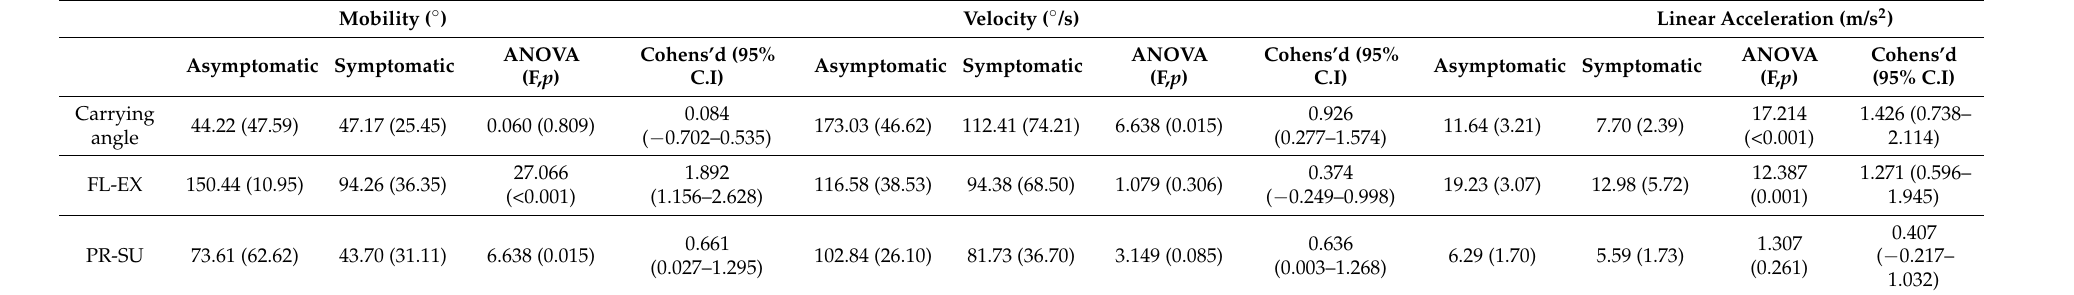
Table 3. Forearm kinematics variables mean (SD) in Asymptomatic subjects and Symptomatic and difference between groups.